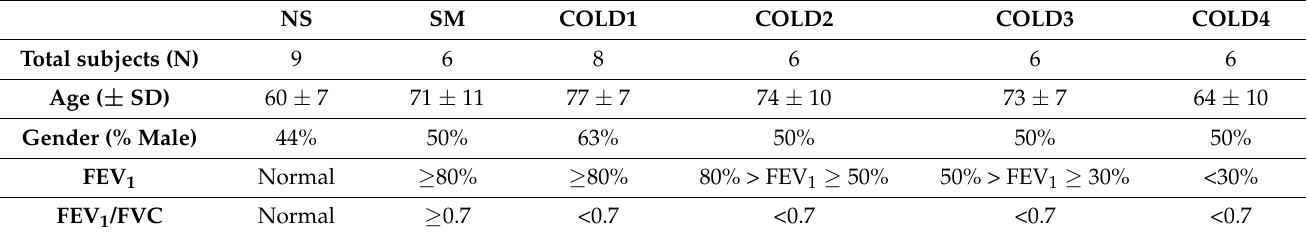
Table 1. Characteristics of the study cohort for analysis of circulating miRNA in